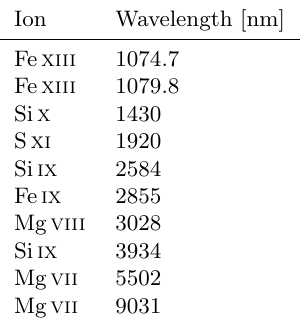
Table 3: Infrared Coronal